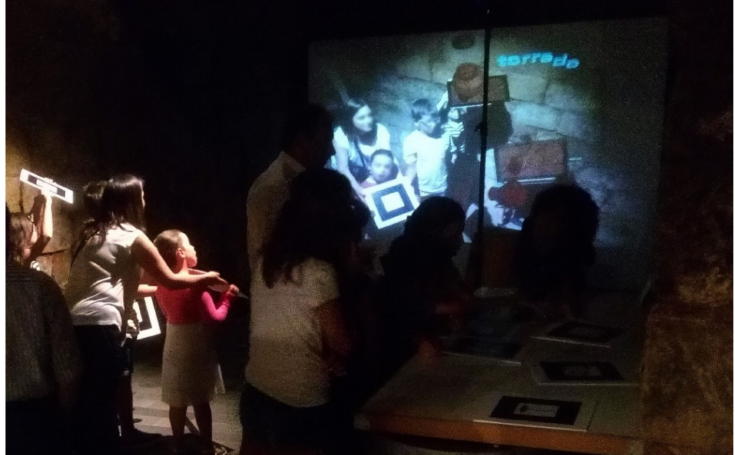
Figure 8. The TinajAR system during the exhibition in Navarrete, Spain.